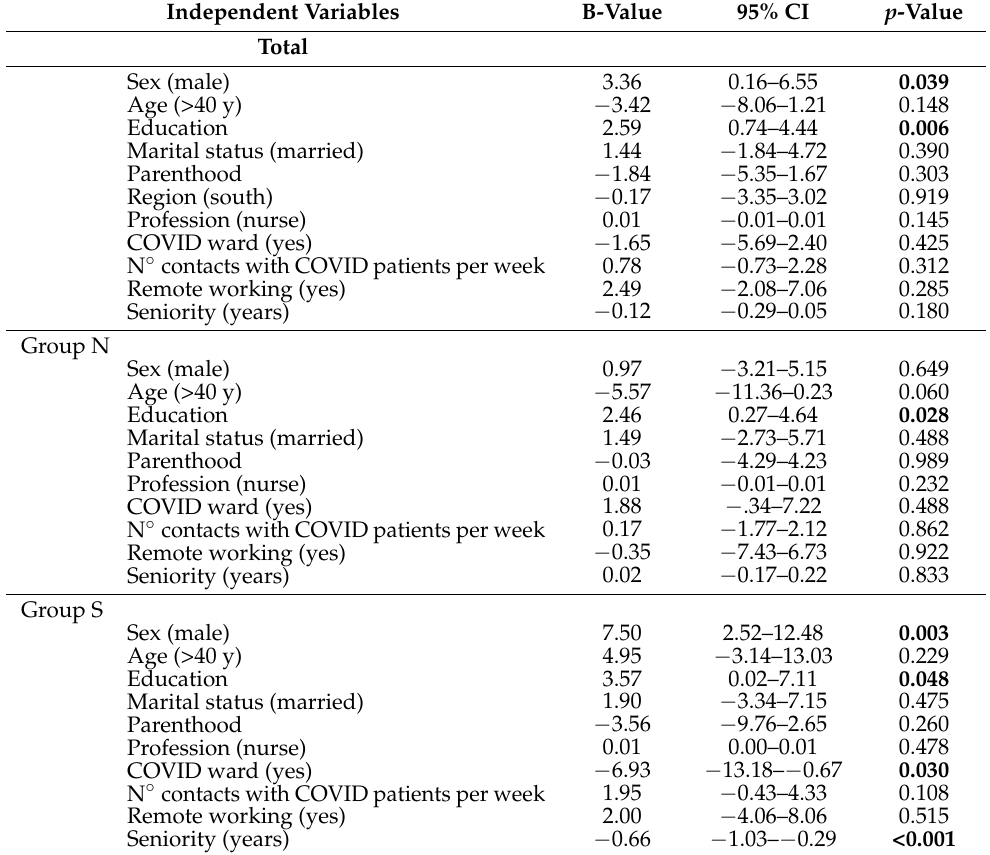
Table 4. Generalized linear model for EQ-VAS, assessing perceived wellbeing in healthcare workers during the first wave of COVID-19 pandemic ( n =